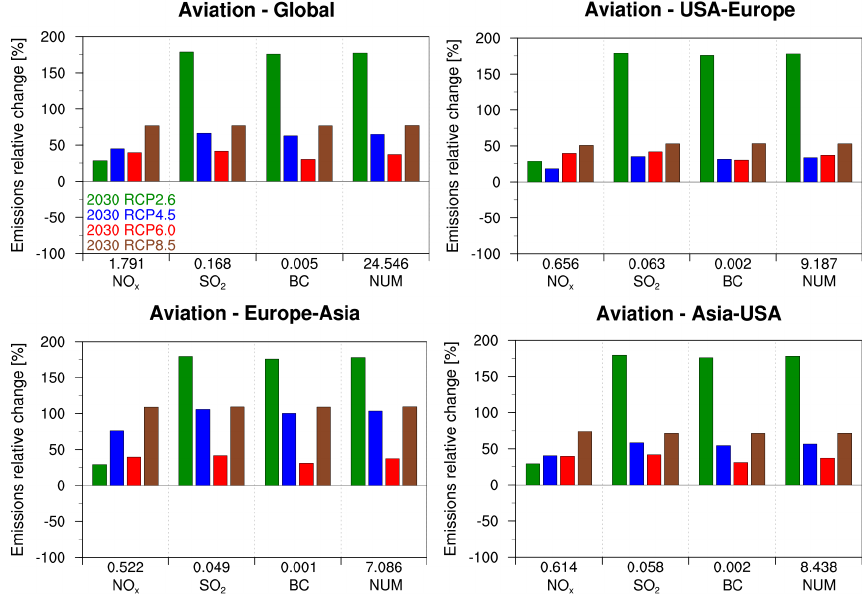
Figure 2. Relative changes in the emissions from aviation in the year 2030 with respect to 2000, for the four RCP scenarios. The changes are displayed globally (top left) and for the regions defined in Fig. 1. Total emissions for the year 2000 are indicated at the bottom of each panel, in units of Tg ( species ) a − 1 for SO 2 and BC, Tg ( NO ) a − 1 for NO x , and 10 25 particlesa − 1 for particle numbers